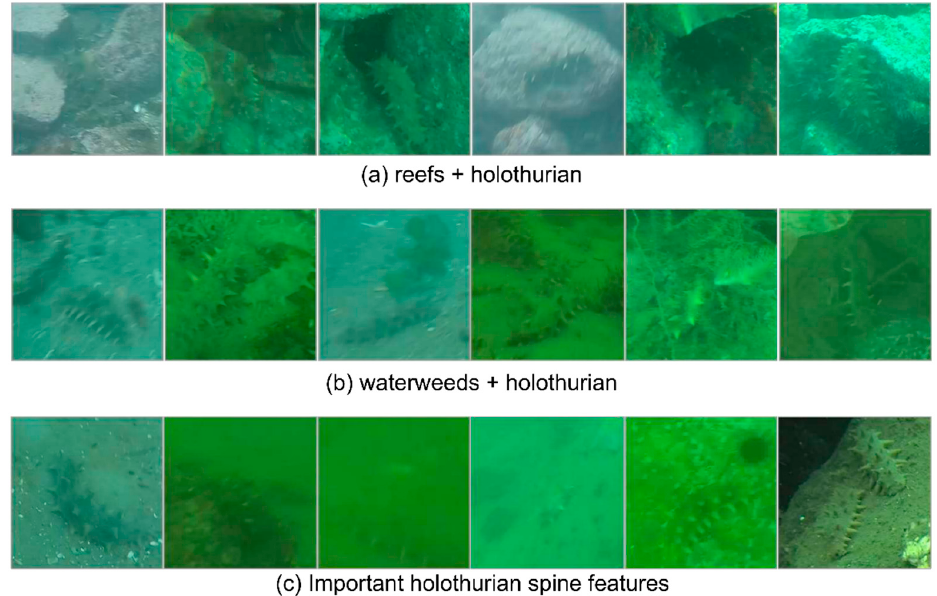
Figure 3. Holothurian scene in the CURPC dataset. ( a ) Reefs and holothurian appear in the same scenario. ( b )Waterweeds and holothurian appear in the same scenario. ( c ) Holothurians whose body features are blurred but can be identified by its spines.